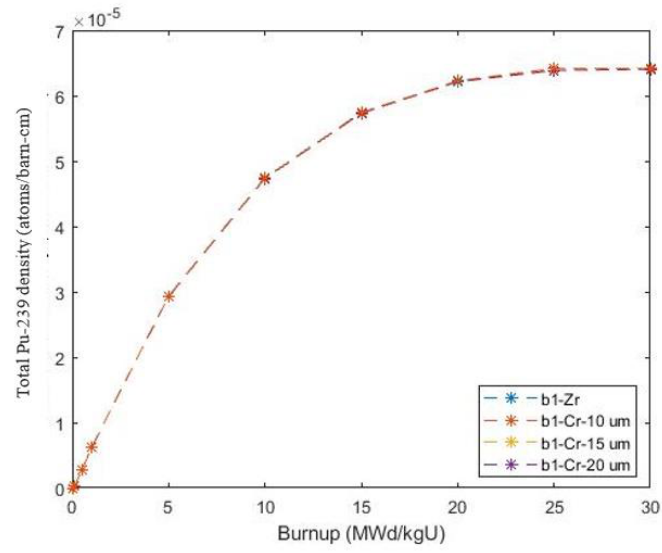
Figure 9. Pu inventory during the life cycle of b1 fuel assembly.